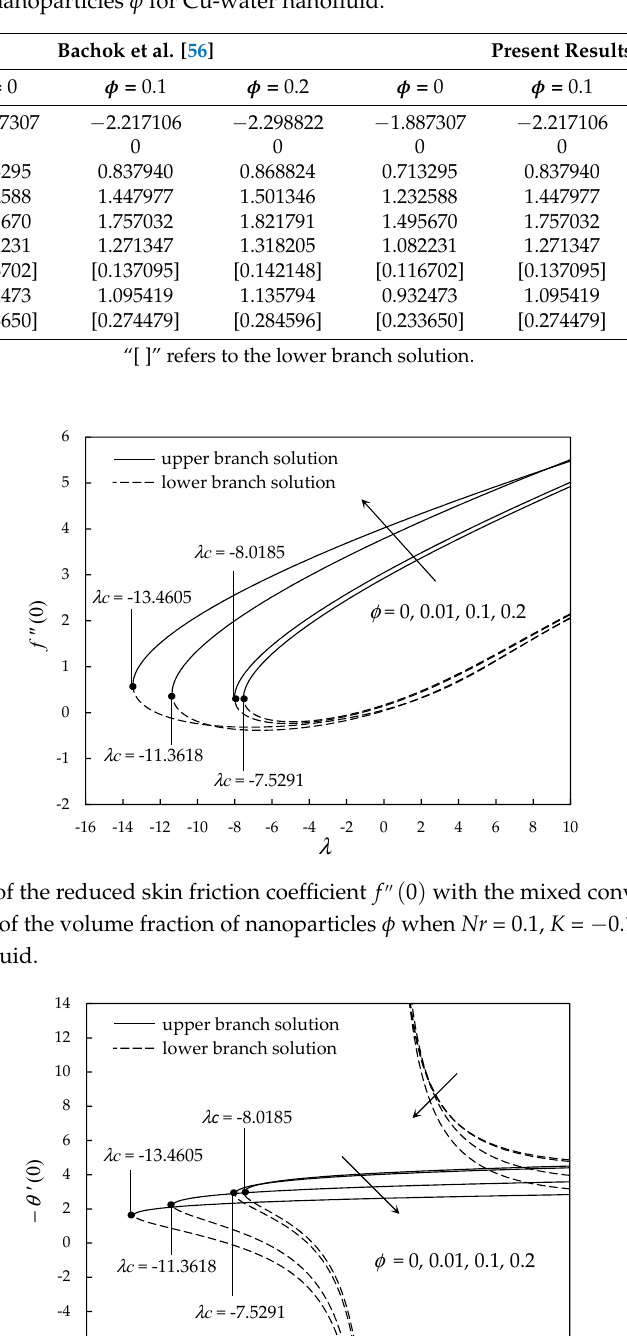
Table 2. Values of 𝑓 (cid:4593)(cid:4593) (0) for various values of the stretching/shrinking parameter c and the solid Table 2. Values of f (cid:48)(cid:48) ( 0 ) for various values of the stretching/shrinking parameter c and the solid volume fraction of nanoparticles 𝜙 for Cu-water nanofluid. volume fraction of nanoparticles φ for Cu-water nanofluid.